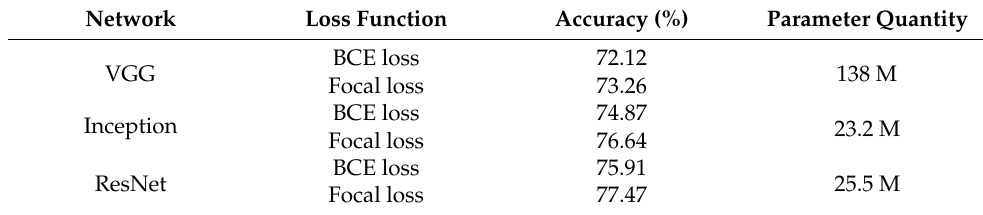
Table 7. Recognition accuracy and loss for different datasets.